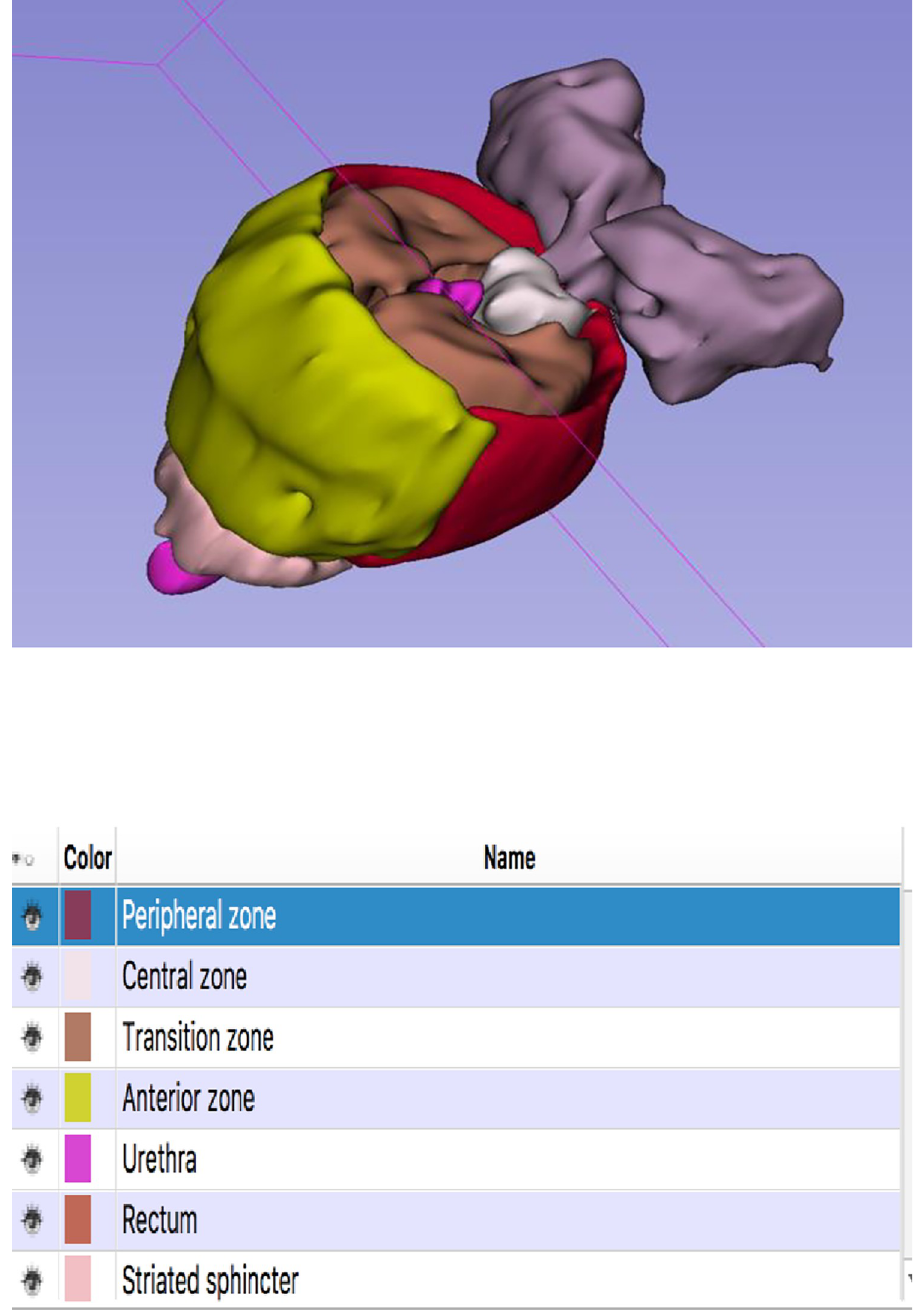
Fig 2. Screen capture of the 3D digital anatomy model, showing McNeal